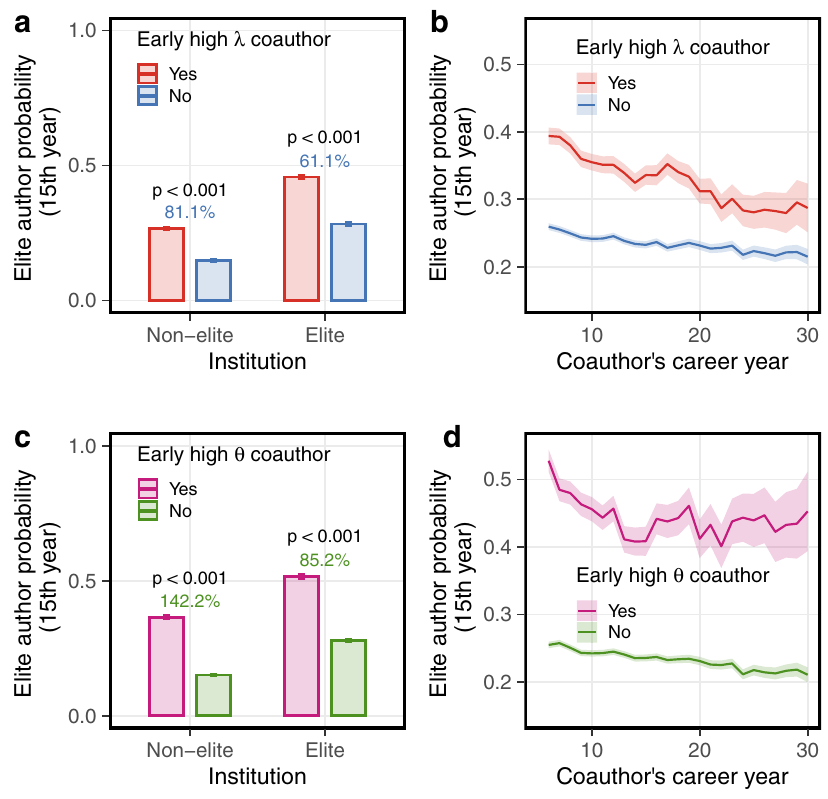
Fig. 3 | Impact of senior coauthors on junior researcher ’ s likely mid-career impact. Earlycareerresearcherswitha( a )high λ or( c )high θ seniorcoauthorsare substantially more likely to be elite authors by their mid-careers, regardless of institutional prestige. The magnitude of this effect for both ( b ) λ and ( d ) θ is large regardless of the career age of the senior coauthor, but decreases modestly with